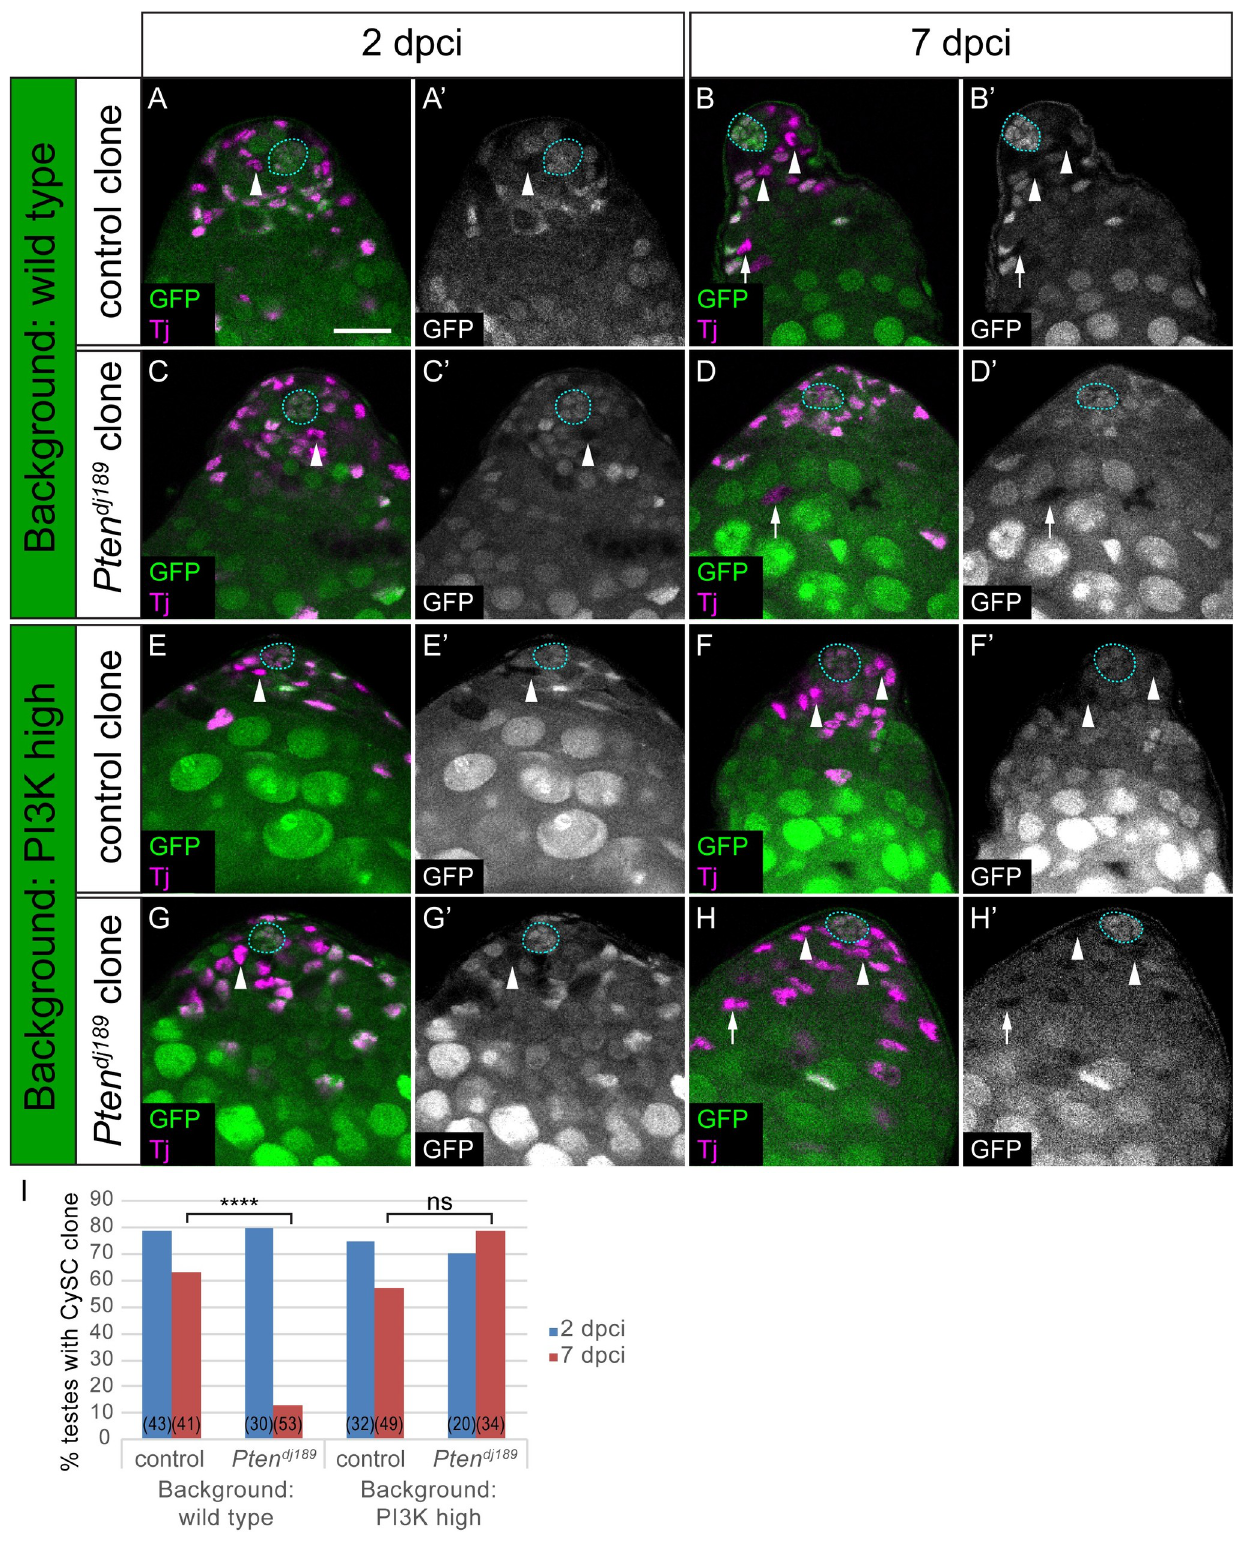
Fig 4. Differentiation of PI3K-high CySCs depends on signalling levels in neighbouring cells. Control (A,B,E,F) and Pten mutant (C,D,G,H) clones induced by mitotic recombination and marked by loss of GFP expression, generated either in a control background ( C587-Gal4 > + , A-D) or in a